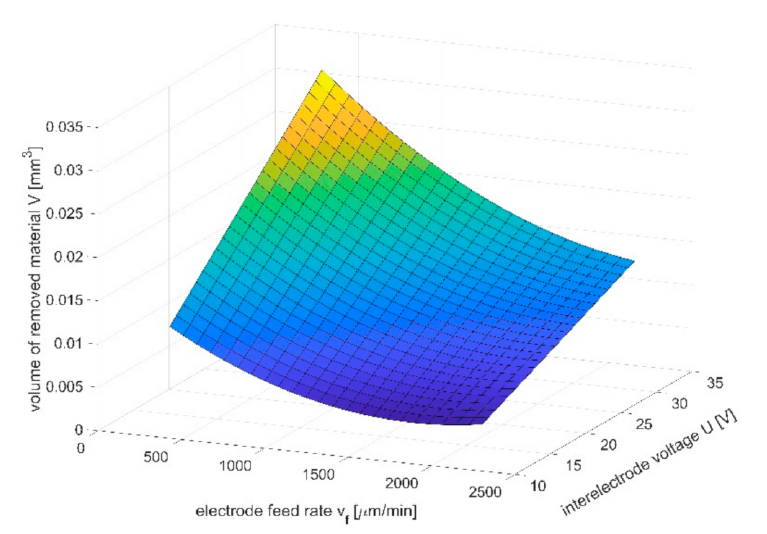
Figure 13. Dependence of the material volume removed in a single electrode pass on the interelec- trode gap S 0 and pulse time t i ; feed rate v f = 1500 µ m/min, interelectrode voltage U = 20